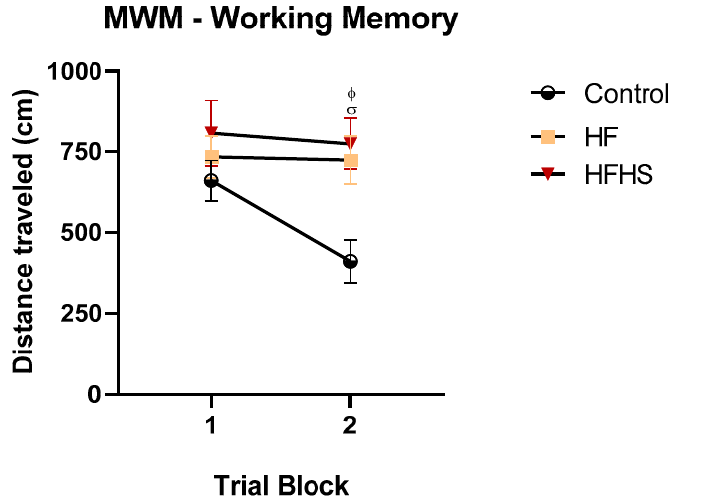
Figure 7. High-Fat High-Sugar, and High-Fat diets impair working memory. The graph illustrates the mean ± SEM of the distance traveled to find the hidden platform during the information and retention trials. HFHS and HF rats traveled long distances to find the platform in the retention trial than the controls. ϕ p < 0.05 HFHS versus control; σ p < 0.05, HF versus control.